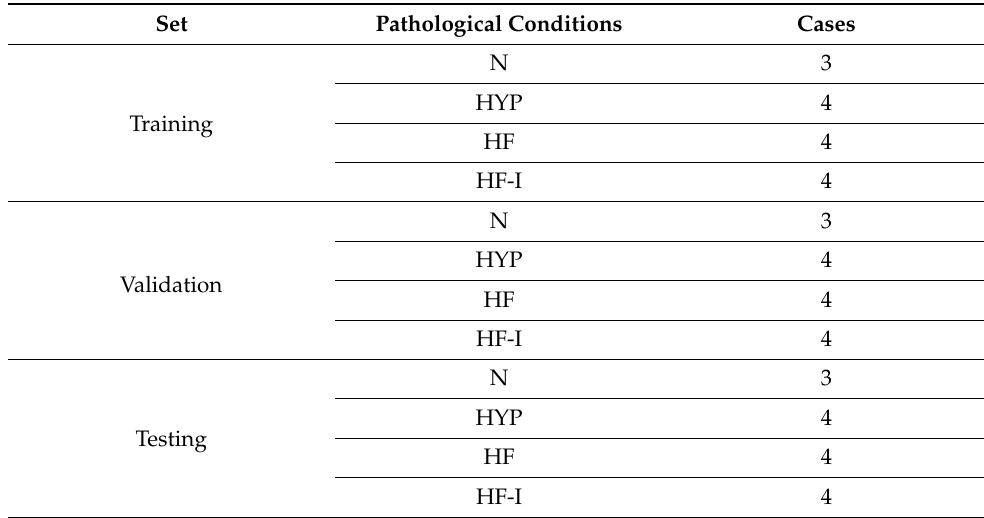
Table 1. Distribution of data into different pathological conditions. Set